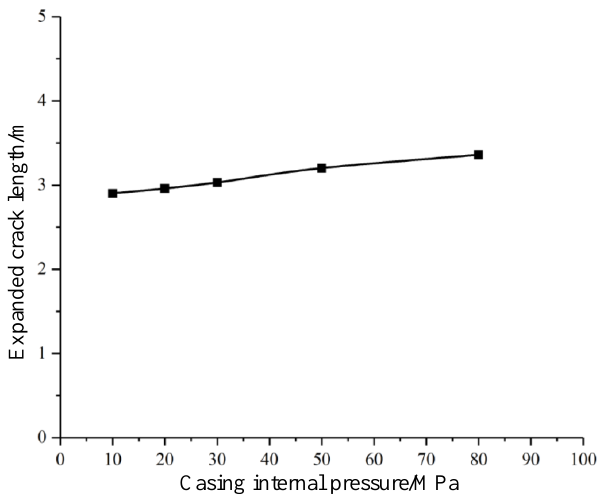
Figure 19. The e ff ect of casing internal pressure on the crack Figure 19. The effect of casing internal pressure on the crack propagation.